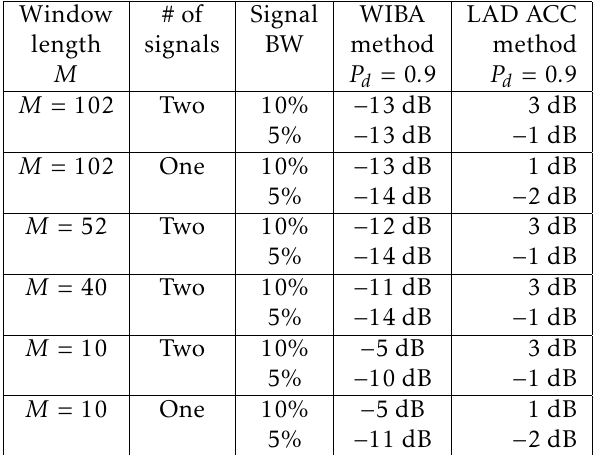
Figure 7. Number of detected signals vs. SNR results. There are two signals with 10% and 5% bandwidths to be detected.